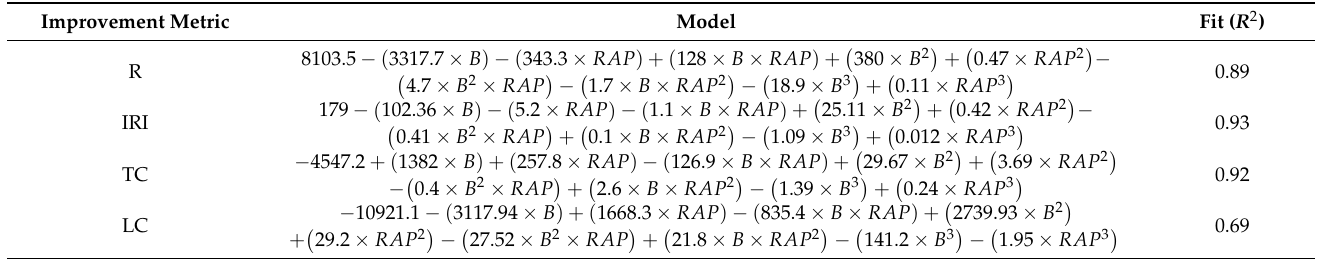
Table 2. Regression models for improvements under dry conditions.